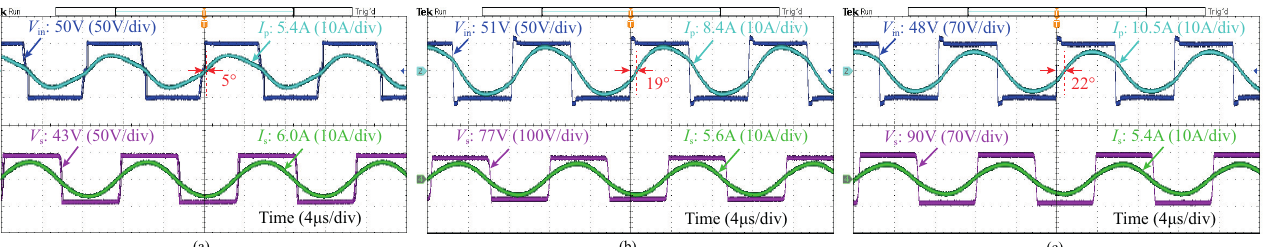
Figure 14. Steady-state experimental waveforms of V in , I p , V s , and I s under ( a ) R B = 10 Ω , ( b ) R B = 20 Ω , ( c ) R B = 25 Ω